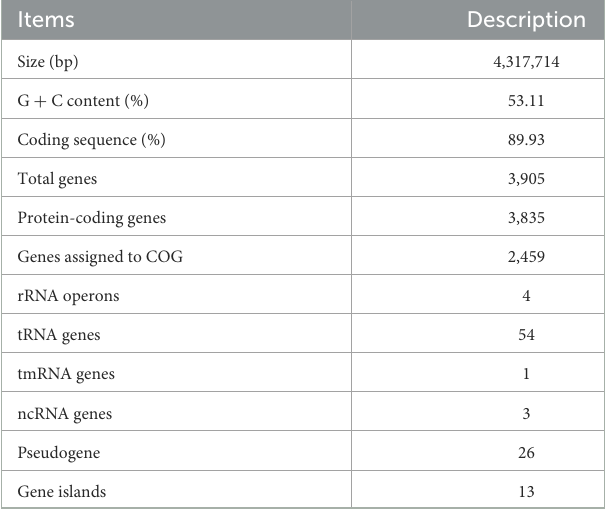
TABLE 1 Genome features of strain